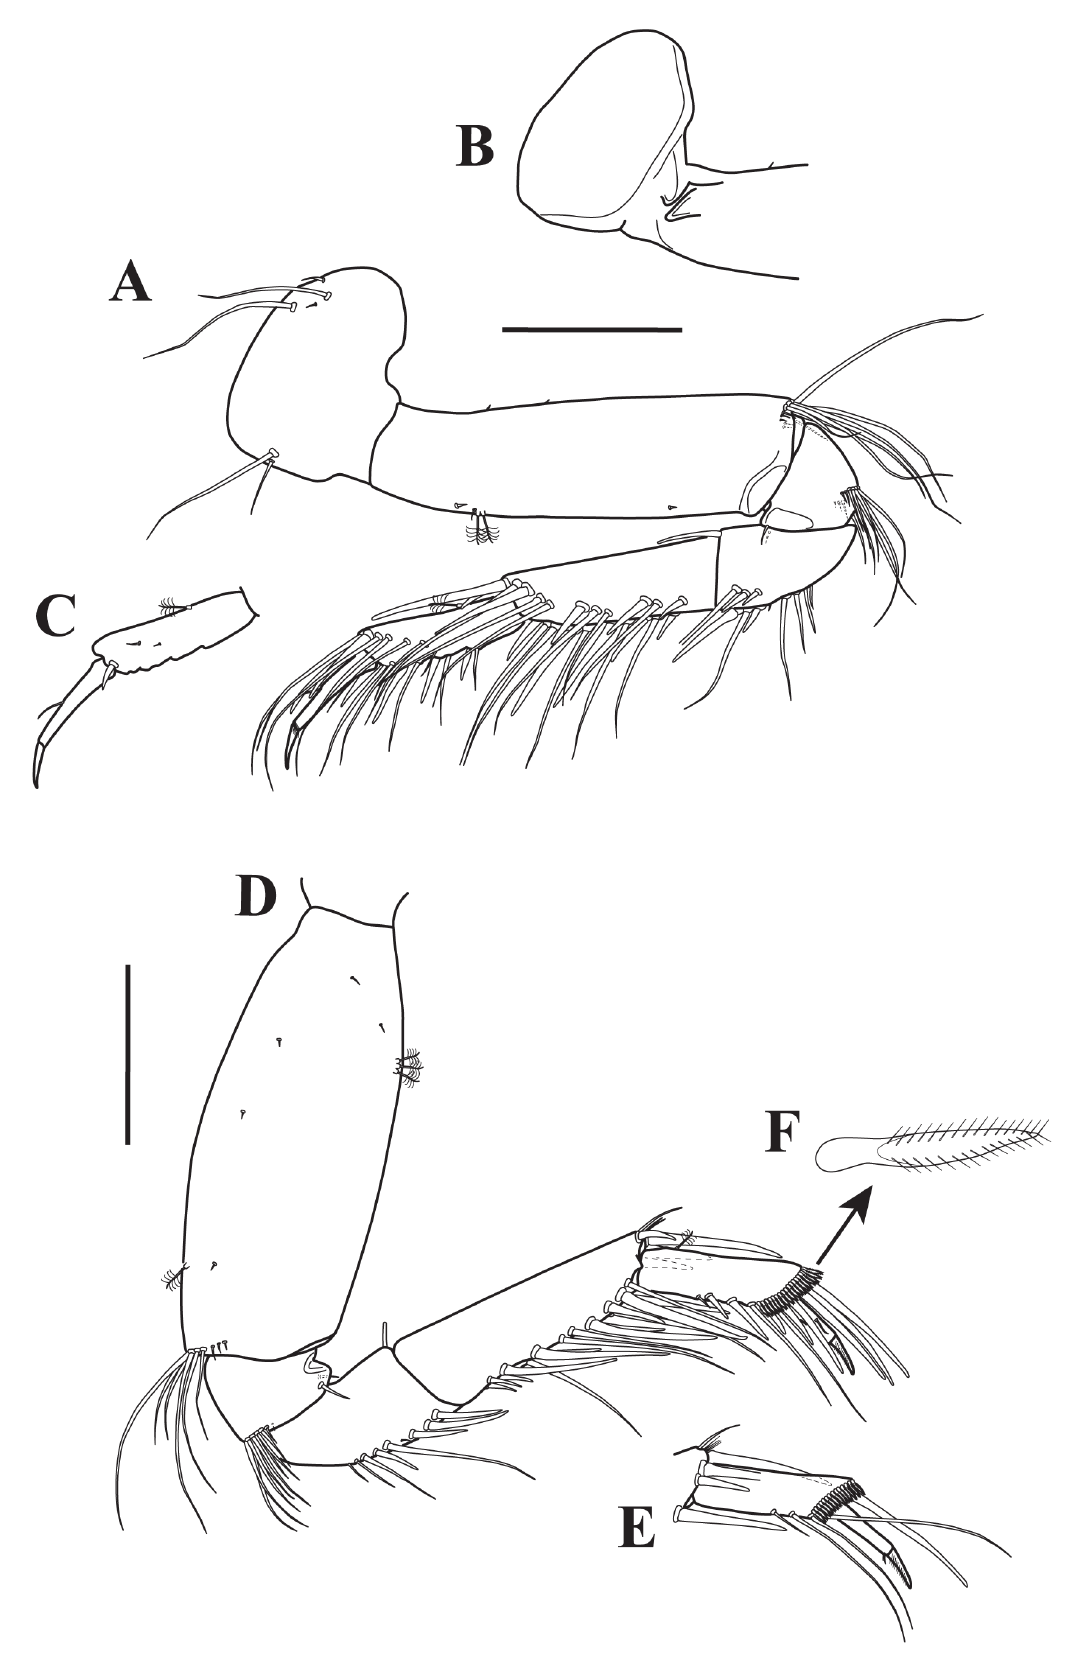
Figure 8. Brachylicoa lui sp. n. holotype female with oostegites and genital cone. A pereopod-3, lateral view; B basis of pereopod-3, inner view; C propodus and dactylus of pereopod-3, inner view; D pereopod-4, lateral view; E propodus and dactylus of pereopod-4, inner view; F enlargement of setulate spiniform, lanceolate setae. Scale bar = 0.5 mm for A − E